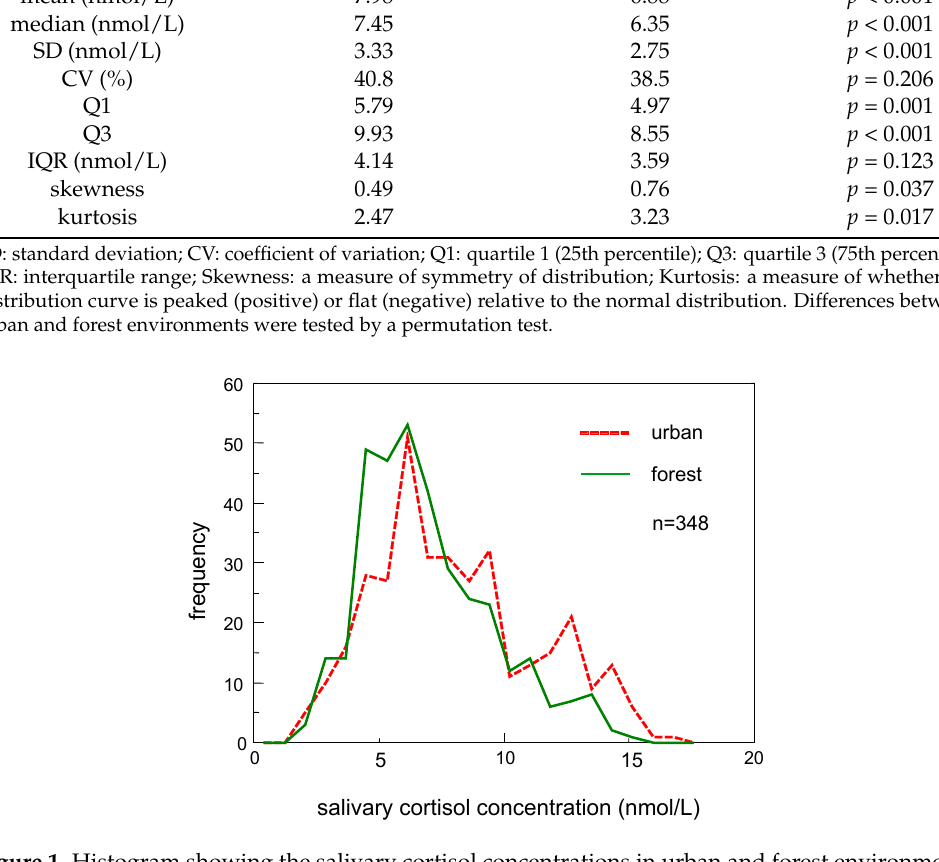
Figure 1. Histogram showing the salivary cortisol concentrations in urban and forest environments. The frequency of subjects with a higher cortisol concentration was lower in a forest environment compared to that in an urban environment.